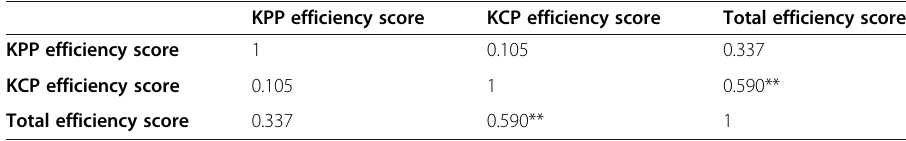
Table 8 Correlation matrix of total innovation performance with